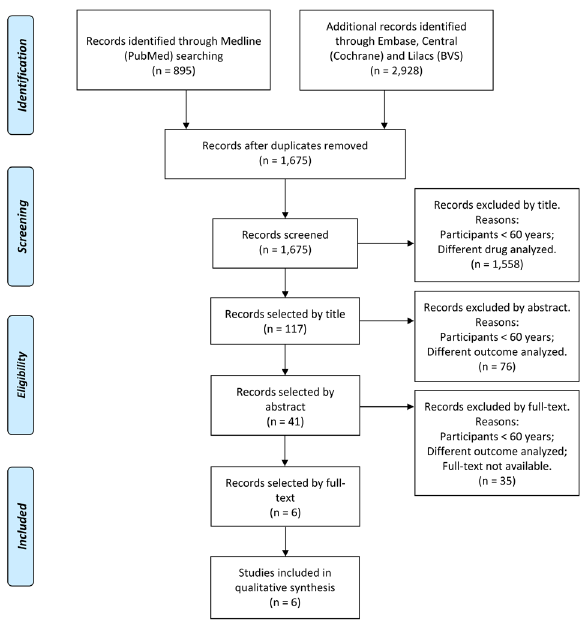
Figure 1. PRISMA flow